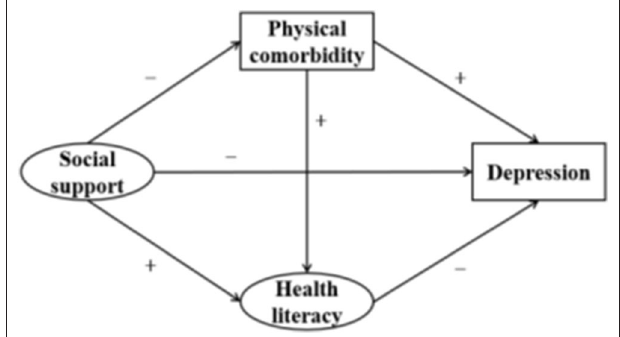
FIGURE 1 | Theoretical model and